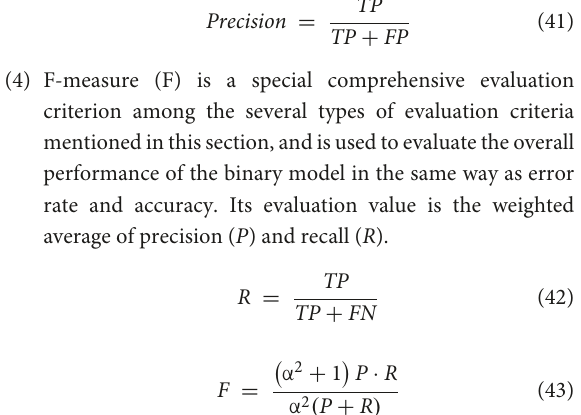
(3) Precision indicates the proportion of true positive prediction instances among all instances discriminated by the classifier as positive prediction